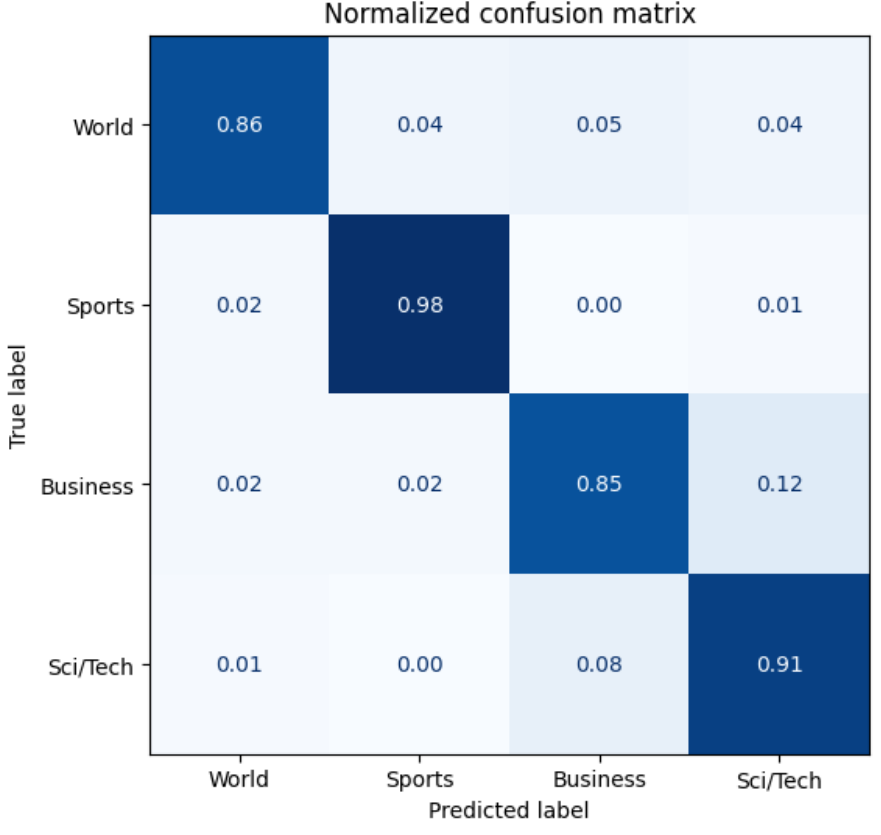
Figure 13. Original Model Confusion Matrix on AG-News.